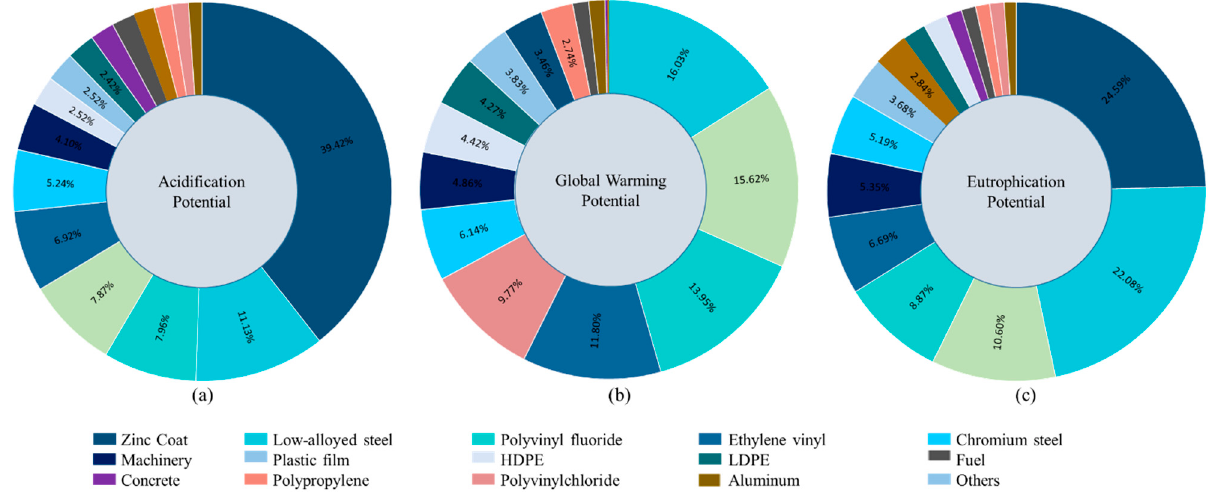
Figure 6. Impact distribution for greenhouse building ( a ) AP, ( b ) GWP and ( c ) EP.